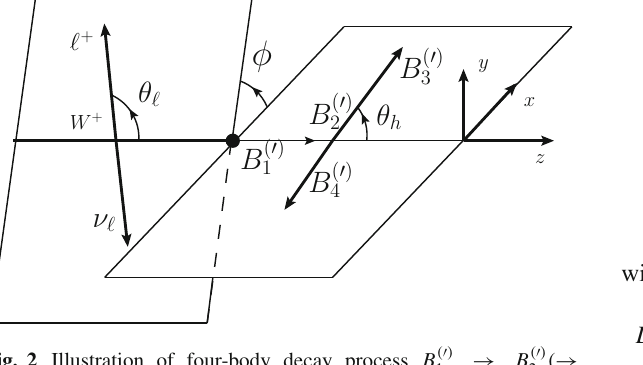
Fig. 2 Illustration of four-body decay process B ( (cid:2) ) )(cid:2) + ν (cid:2) B ( (cid:2) ) B ( (cid:2) ) 3 4